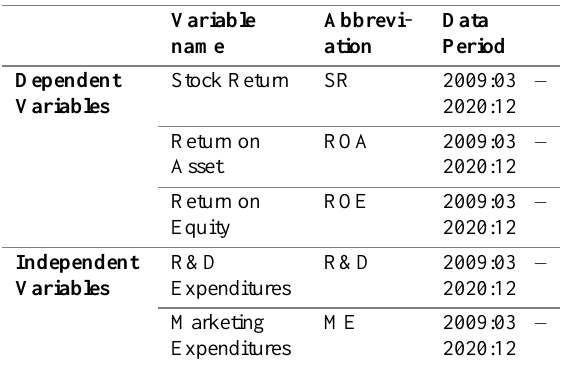
Table 2. Variables in the model